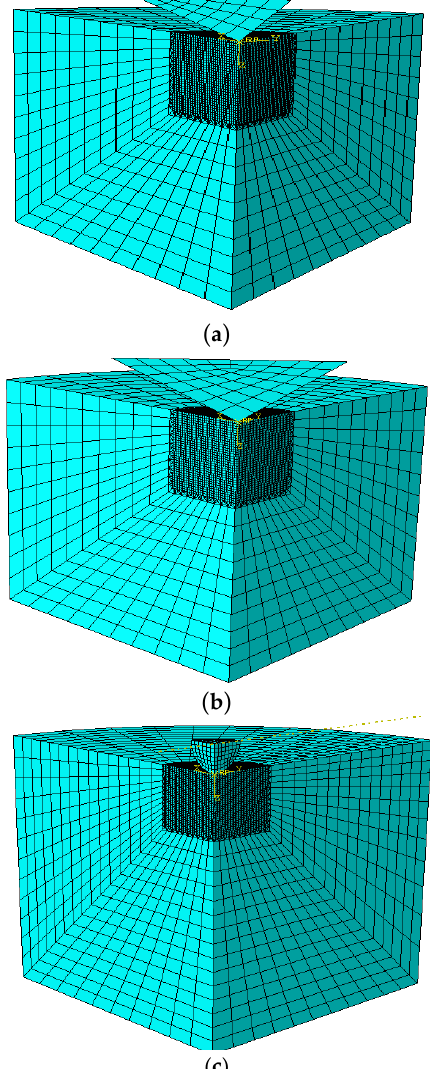
Figure 1. ( a ) FE model of Berkovich indentation. ( b ) FE model of Vickers indentation. ( c ) FE model of spherical indentation.